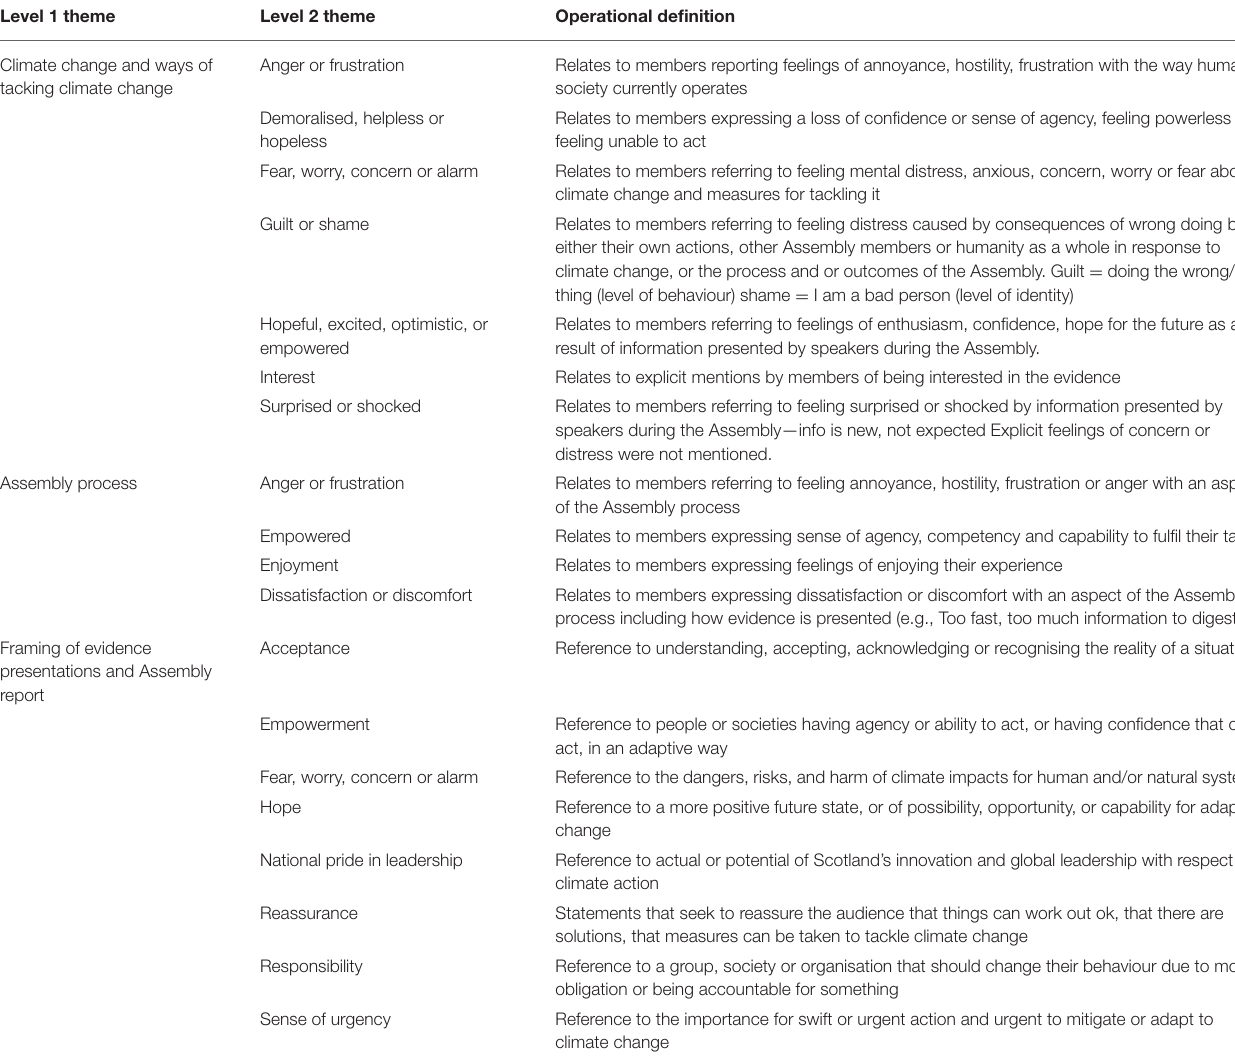
TABLE 2 | Coding framework and definitions. Level 1